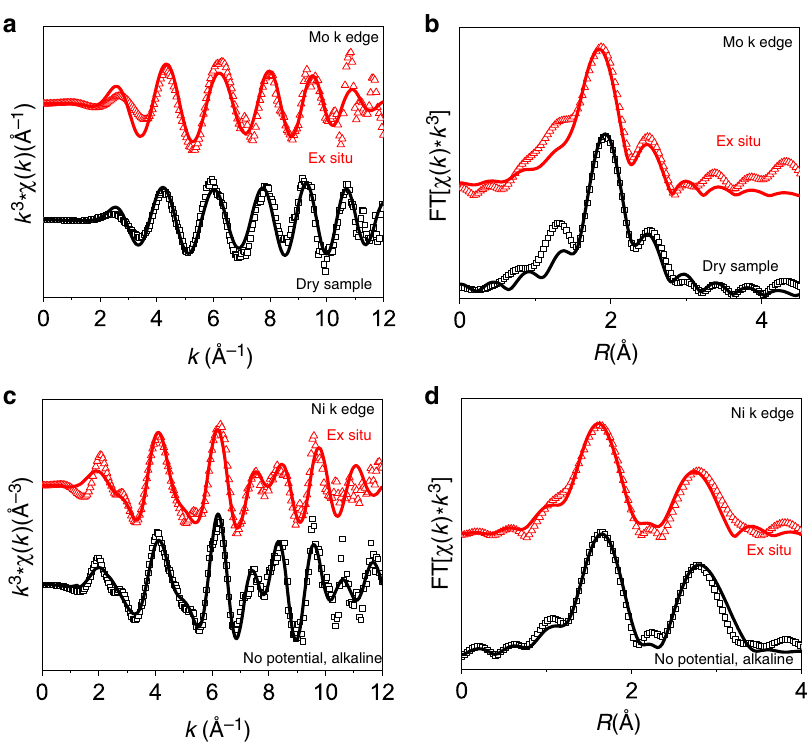
Fig. 5 Ex situ XAS after alkaline electrocatalysis. a Mo K edge K-space spectra and b R-space spectra and c Ni K edge K-space spectra and d R-space spectra ex situ EXAFS results, which are compared to the applicable results in this work.